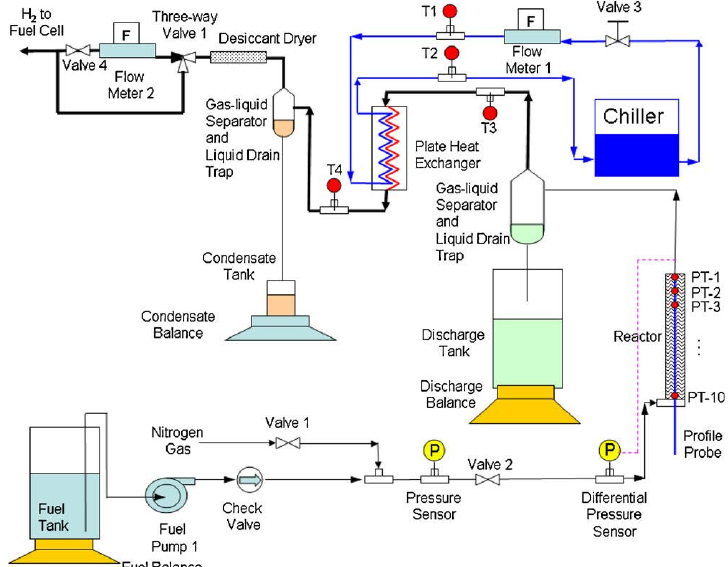
Figure 4. Schematic of the 1 kW e NaBH 4 hydrogen generation system. Reprinted with permission from reference [83]. Copyright 2007 Elsevier.